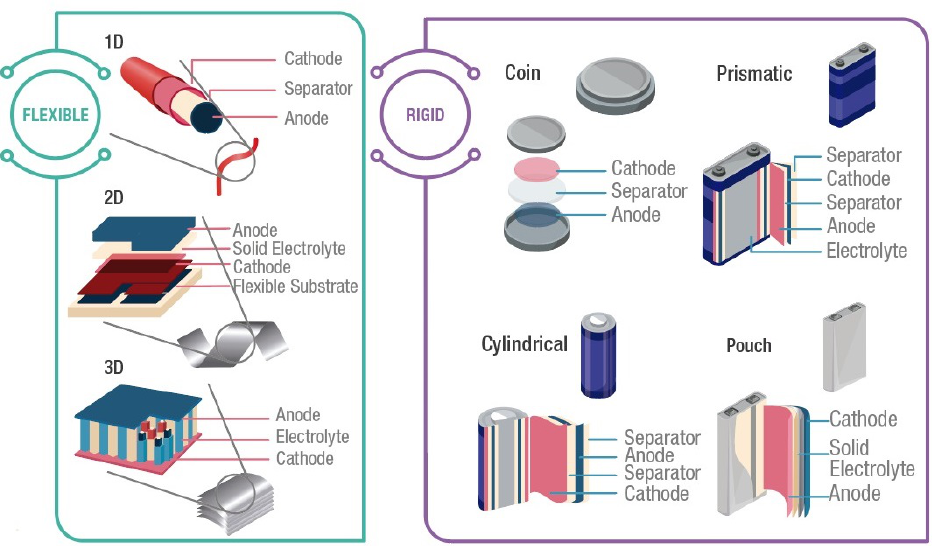
Figure 3. Typical battery configurations. Flexible: 1D, 2D, and 3D. Rigid: coin, cylindrical, prismatic, and pouch. Graph constructed by the